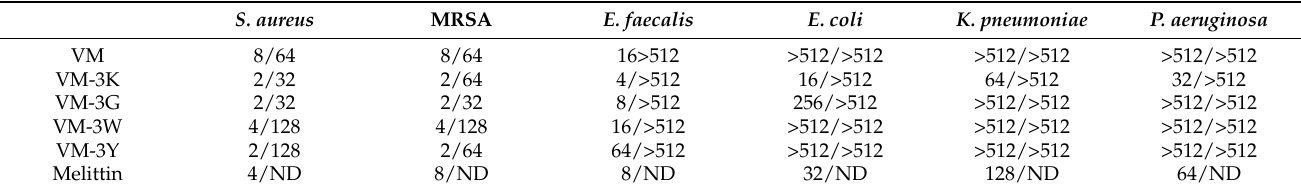
Table 5. MBICs ( µ M) and MBECs ( µ M) of VM and its four designed analogues against the test bacteria. Data were collected in nine replicates from three independent experiments. ND means not detected.